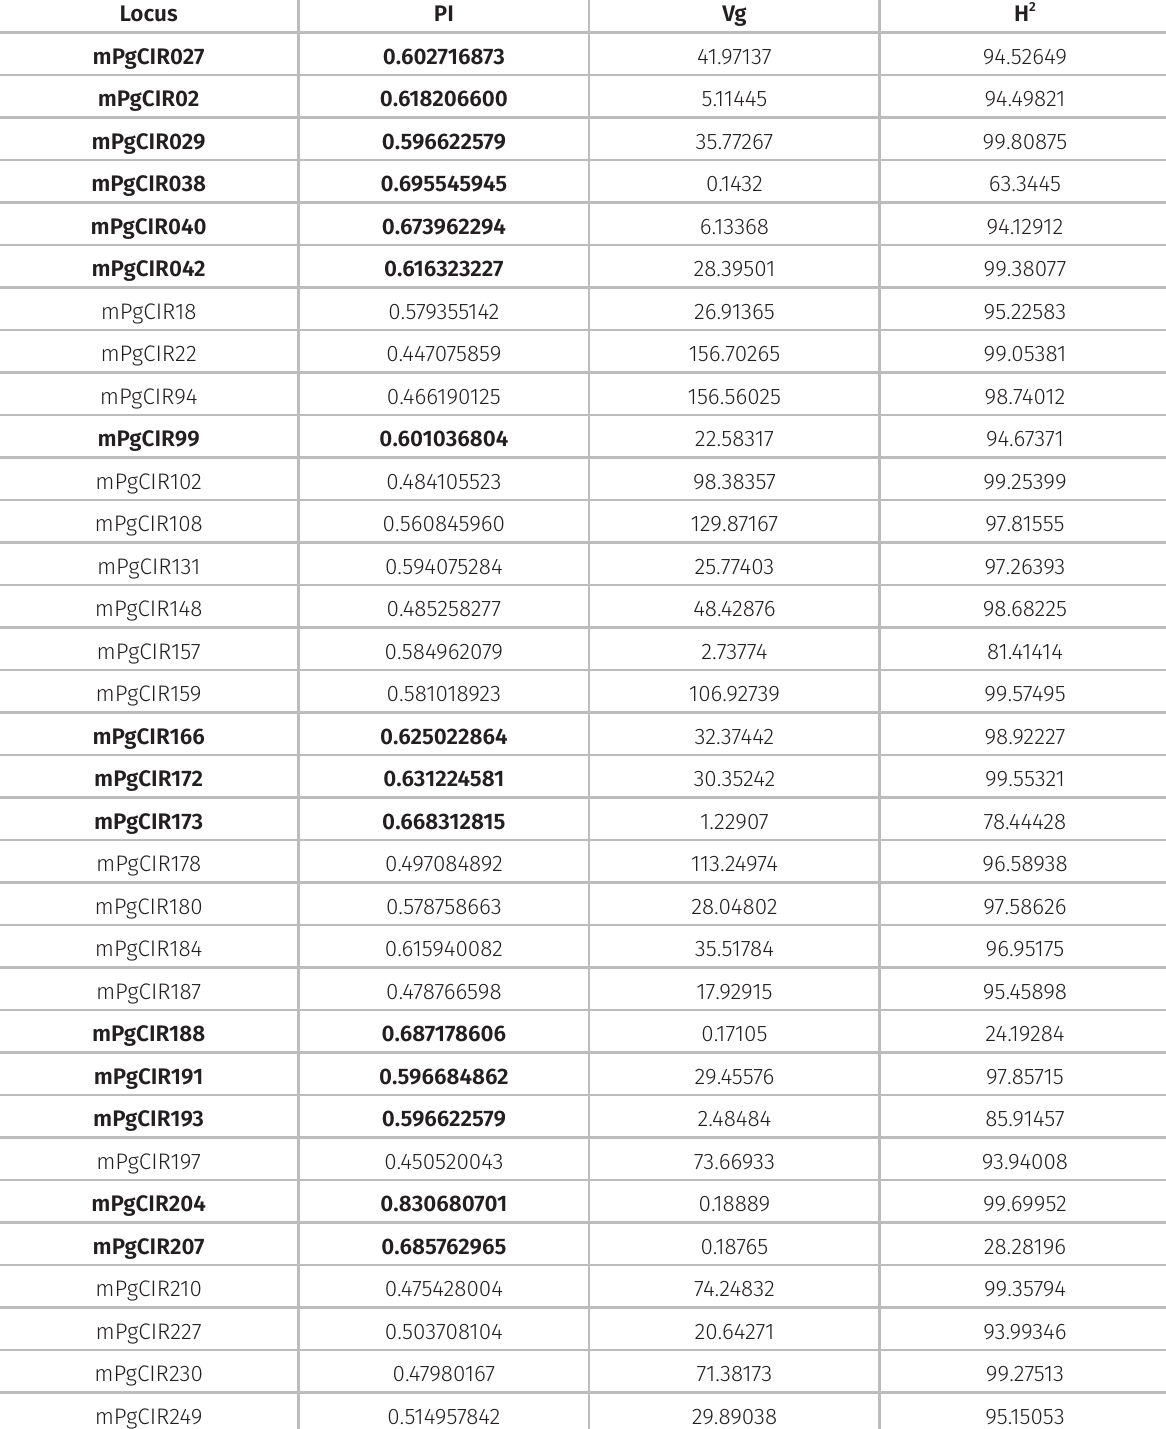
Table V. Probability of identity (PI), genetic variance (Vg), and genotypic determination coefficient (H 2 ) estimated for 33 loci analyzed in 94 individuals originating from five populations obtained from interspecific crosses of Psidium